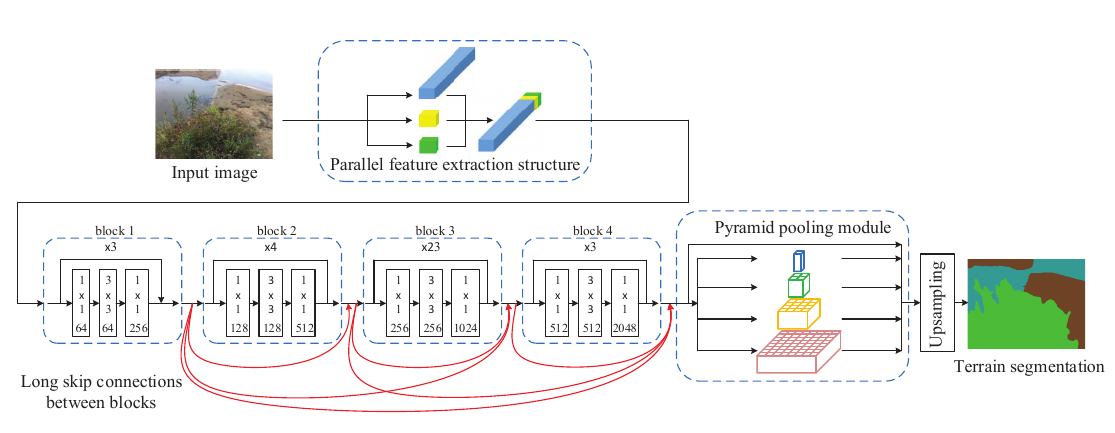
Figure 9. Complete structure of